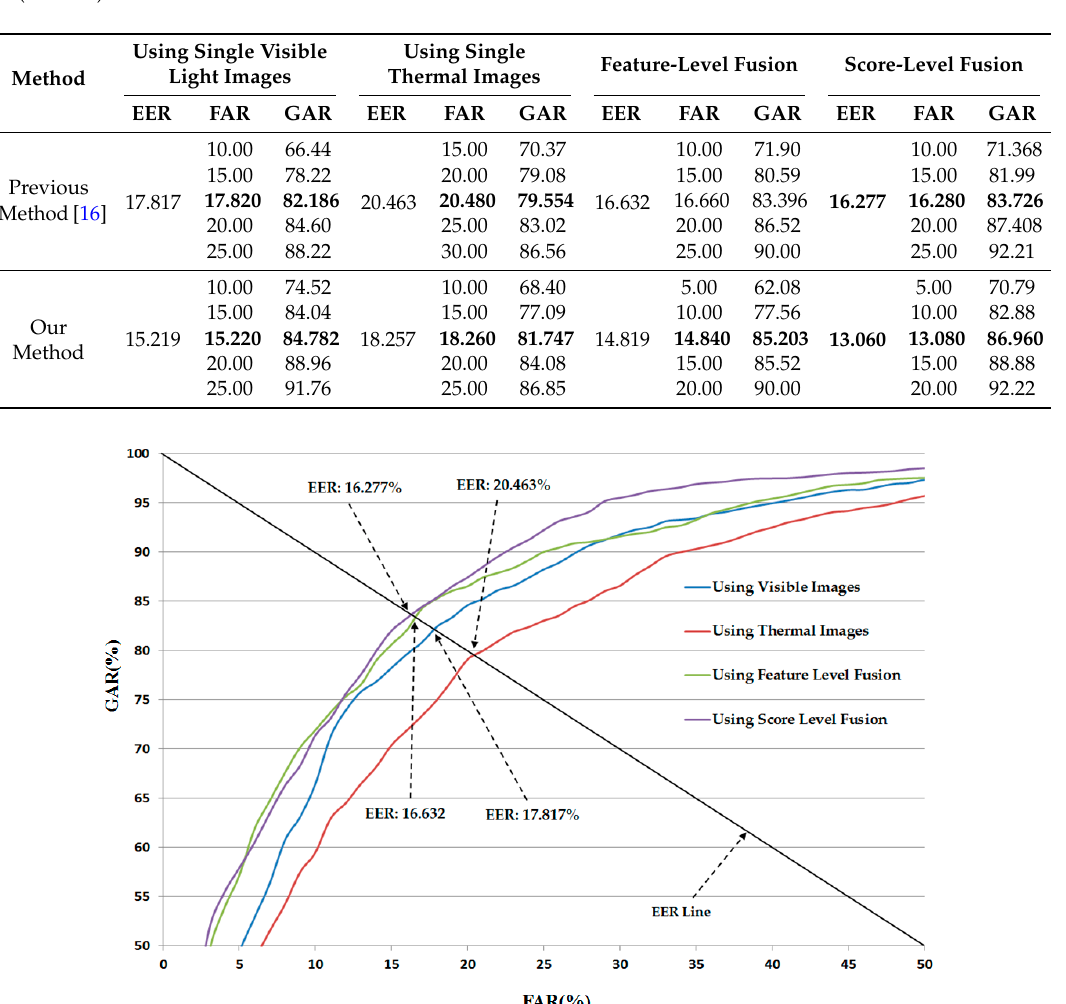
Figure 7. The average ROC curve of a previous recognition method [16] with different kinds of images and combination methods.